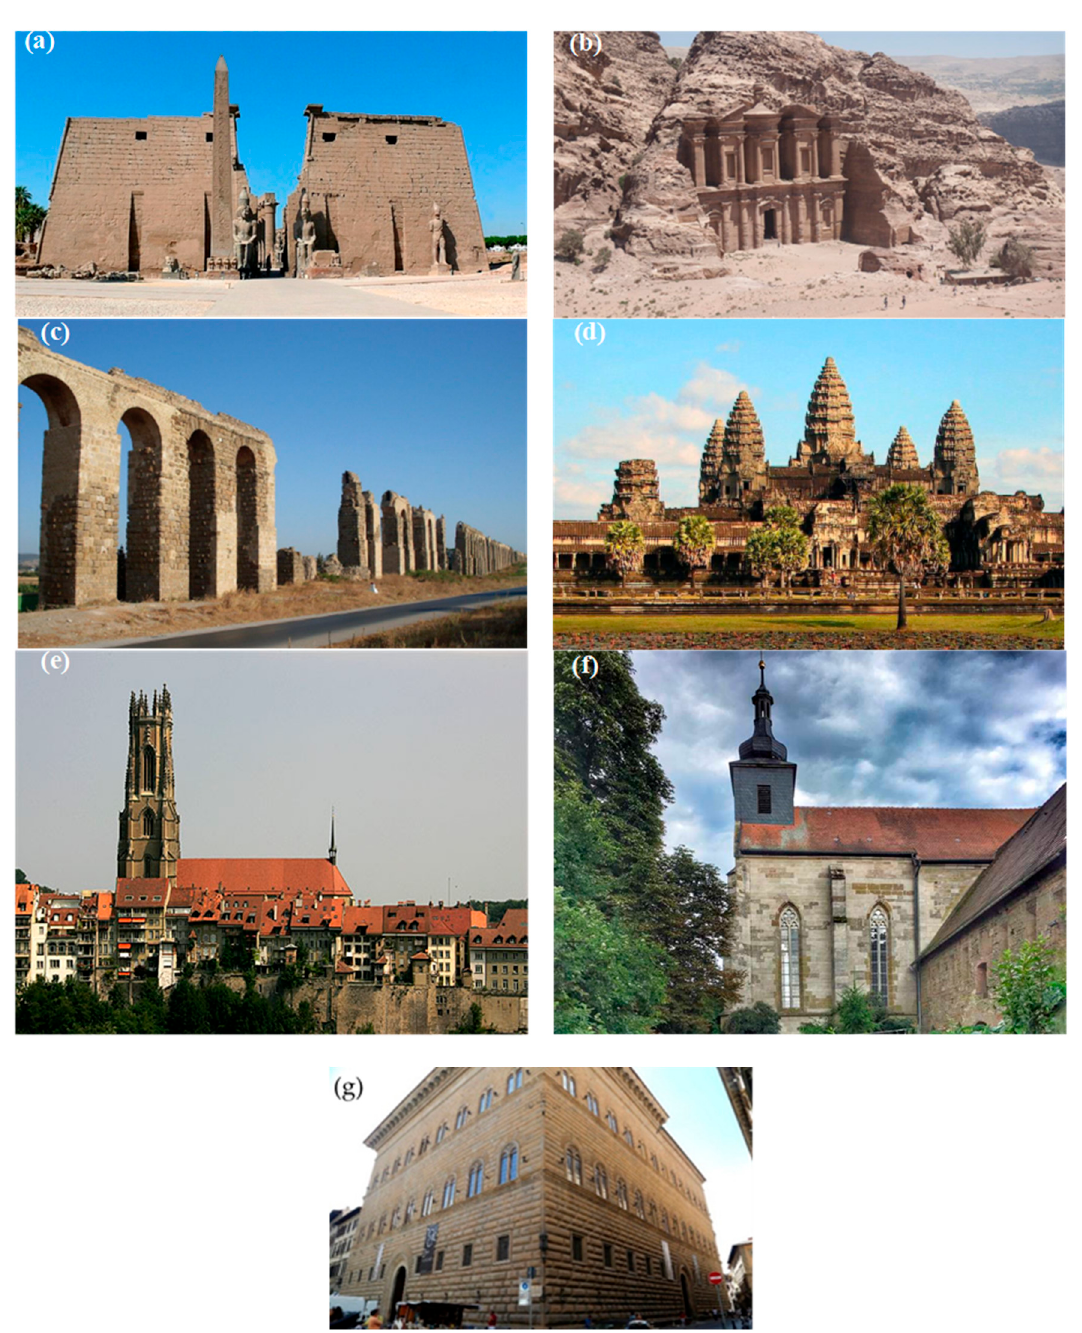
Figure 1. Sandstone monuments in the world. ( a ) Luxor temple in Tebas (Upper Egypt); ( b ) El Deir (“The Monastery”) in Petra (Jordan); ( c ) Carthage aqueduct in Tunisia; ( d ) Angkor Wat in Cambodia; ( e ) St. Nicolas Cathedral in Switzerland; ( f ) Birkenfeld Monastery in Germany; ( g ) Strozzi Place in Florence (Italy).